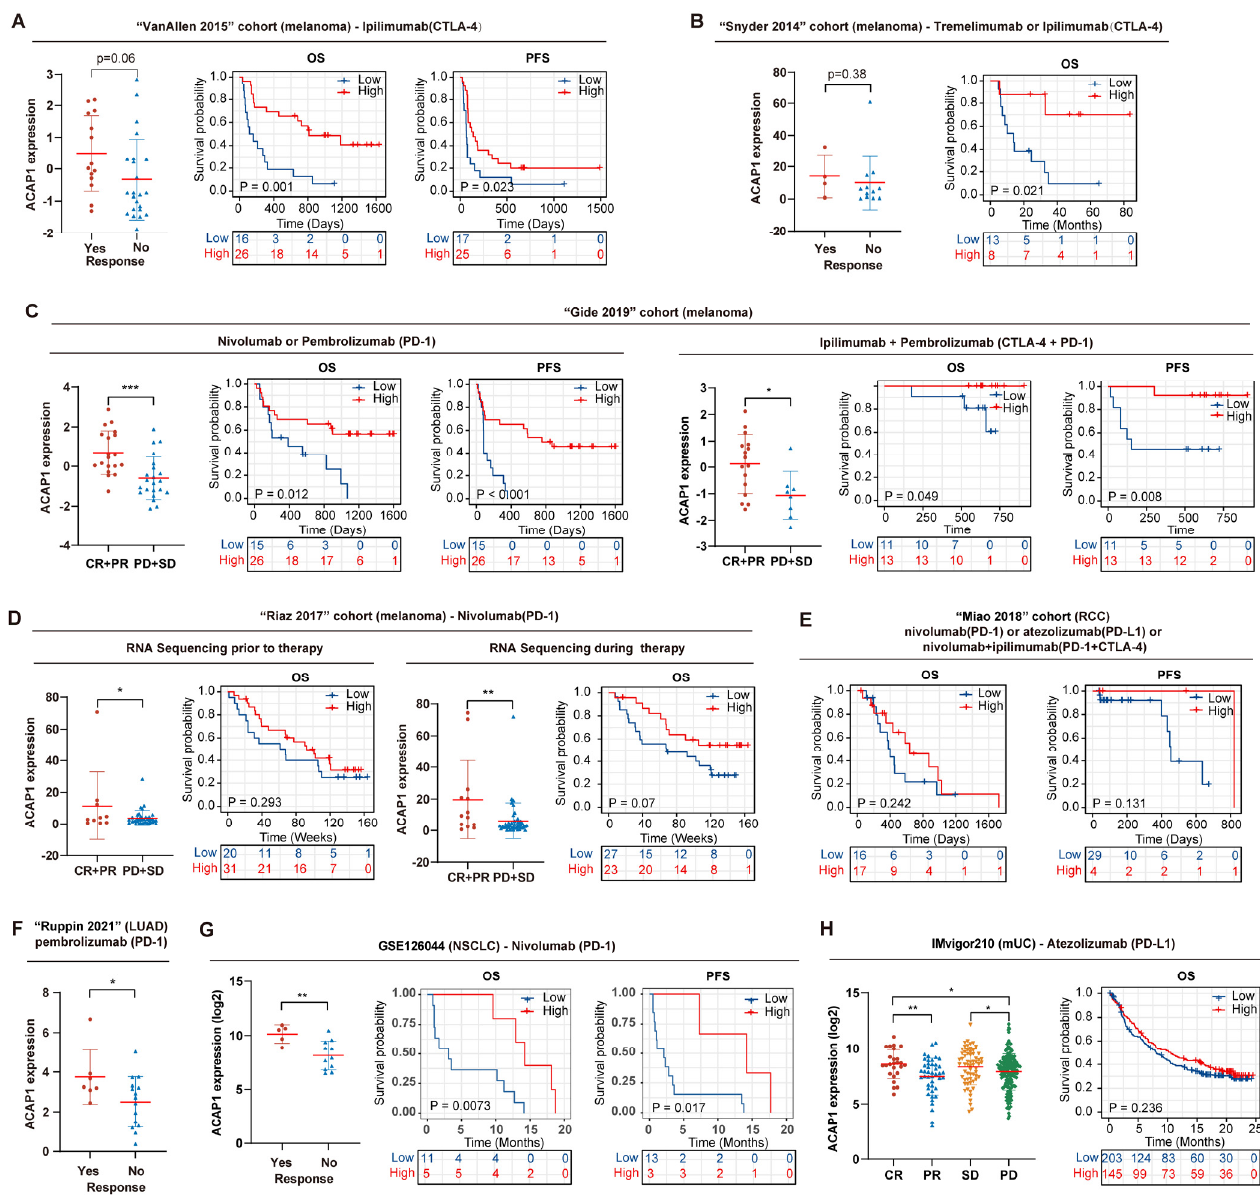
Figure 9. ACAP1 deficiency correlates with inferior ICT response and prognosis in multiple cancer types. ( A ) ACAP1 expression in different response groups; Kaplan–Meier OS and PFS estimates